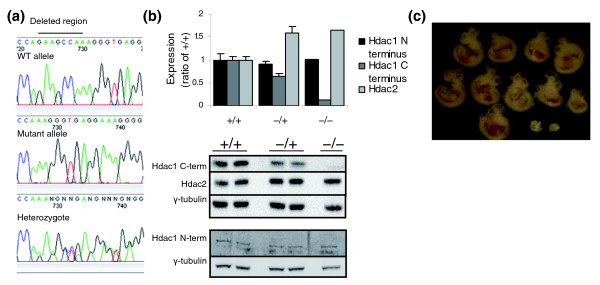
A mutation in Hdac1 correlates with the MommeD5-/- phenotype. (a) A 7 bp deletion was detected in exon 13 of Hdac1. Representative chromatograms from the wild-type (WT) allele, the mutant allele, and one heterozygote are shown. This deletion alters the reading frame, changing the last 12 amino acids and adding 25 extra amino acids. (b) Whole-cell lysates from six individual 10.5 dpc MommeD5+/+ and MommeD5-/+ embryos, and six pooled MommeD5-/- embryos were probed with antibodies to the Hdac1 carboxyl terminus (top panel), Hdac2 (top panel) and Hdac1 amino terminus (bottom panel). Anti-γ-tubulin was used as a loading control in each case. Quantification of the Hdac1 carboxyl terminus relative to γ-tubulin shows negligible binding in MommeD5-/- mice. Quantification of Hdac2 levels relative to γ-tubulin shows increased Hdac2 in MommeD5-/+ and MommeD5-/- embryos. Quantification of Hdac1 amino terminus relative to γ-tubulin shows equal levels of Hdac1 in all mice. A peptide blocking experiment was performed to confirm band identity. A representative western blot is shown. Error bars represent SEM. (c) A representative litter from a MommeD5-/+ intercross at 10.5 dpc. MommeD5-/- embryos (bottom right) are always dramatically smaller than MommeD5+/+ and MommeD5-/+ littermates.